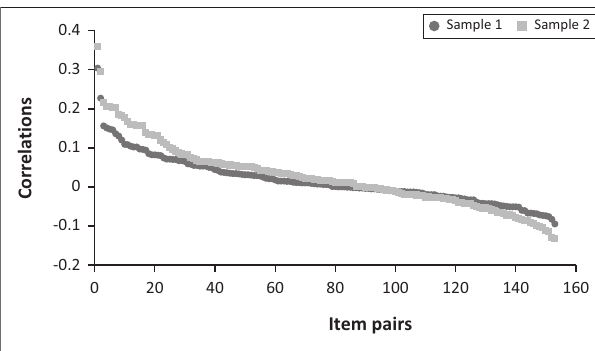
FIGURE 6: Ranked correlated residuals: 1-factor (Fact R3M )